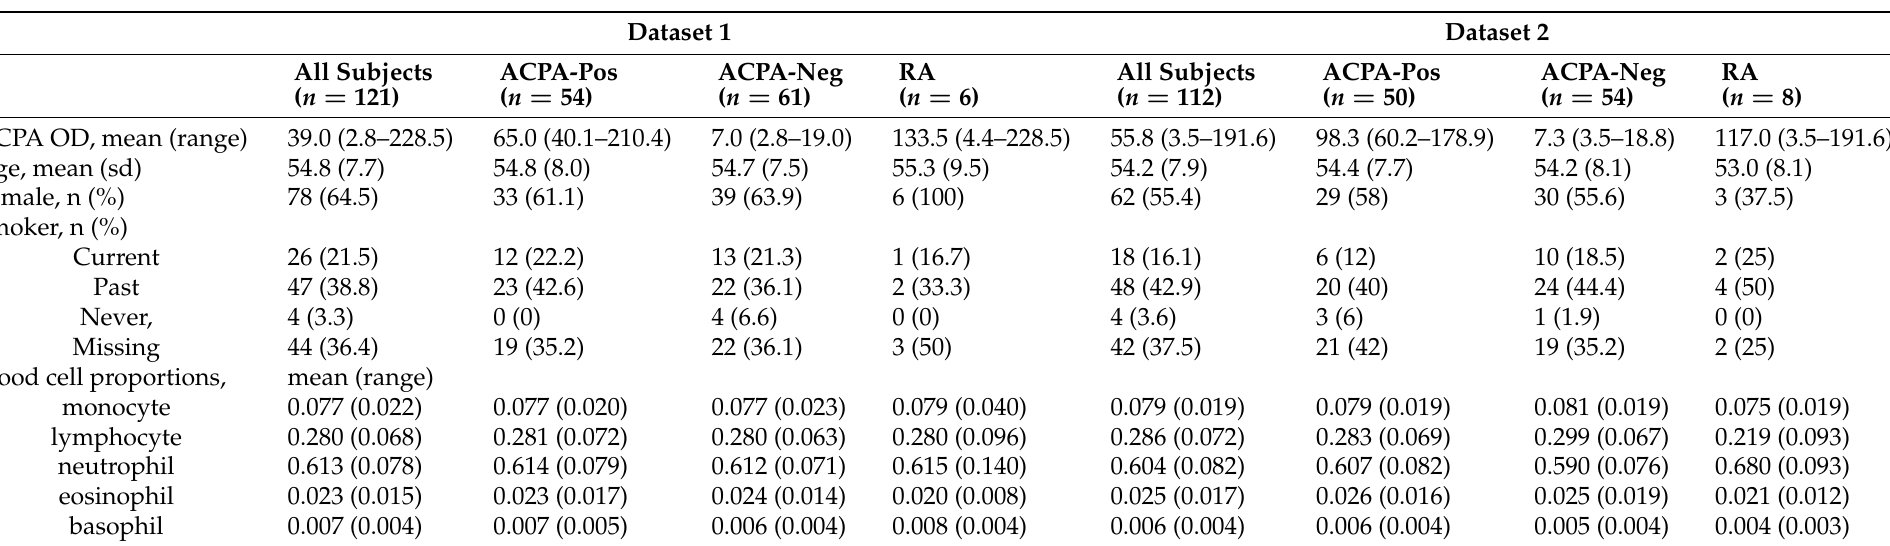
Table 1. Demographics of participants in initial study (Dataset 1) and current replication study (Dataset